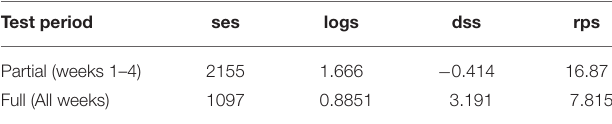
TABLE 3 | Performance of model-based forecasting (4 scores) for Pst disease (i.e., disease risk) within southern Alberta in 2015 for a partial and complete season lead-time, using the best training case (case 3) of the hhh4